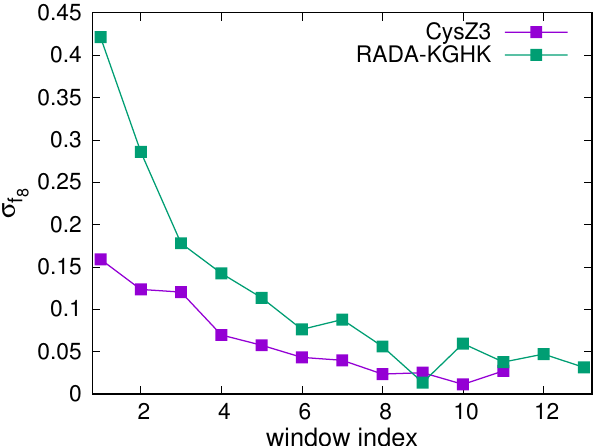
Figure 1. Plots of the standard deviation of the fraction of octamers ( σ f window, except from the last one, from that of the last simulation window for the CysZ3 and RADA-KGHK systems. The graph was drawn with gnuplot